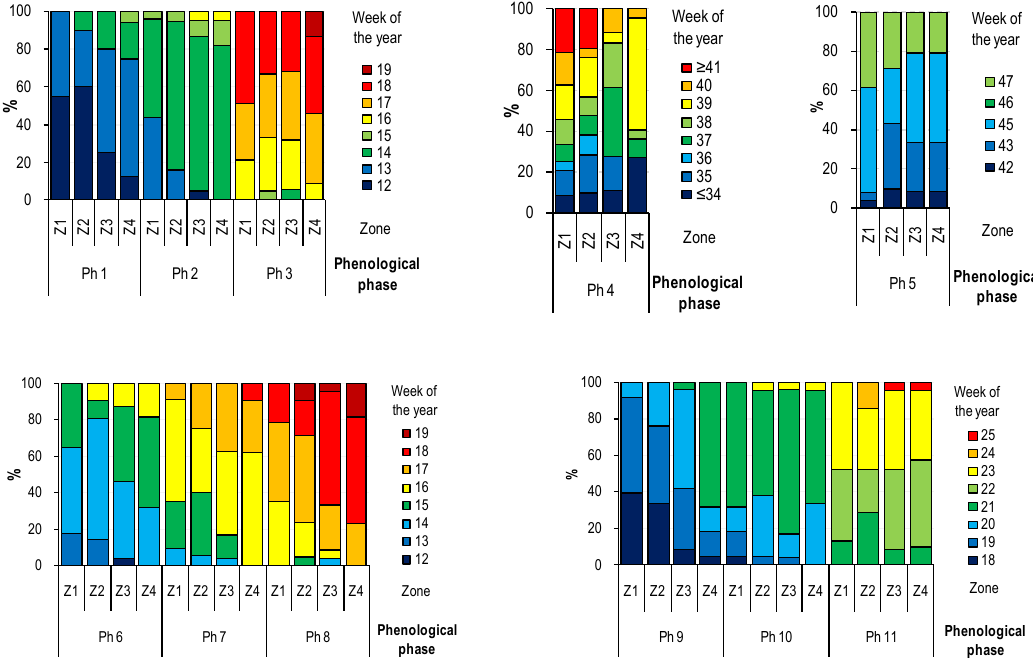
Figure 3. The frequency of occurrence of selected phenological phases (Ph1–Ph11) depending on the distance from the city center (BBCH code see Table 3).